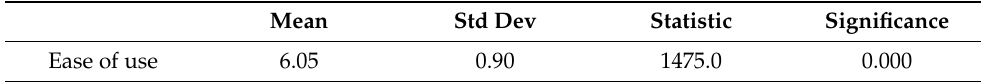
Table 14. Wilcoxon signed rank